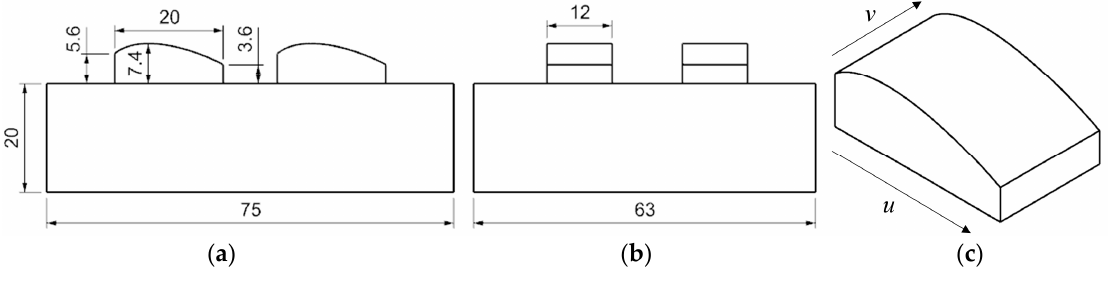
Figure 2. Design of Surface one; ( a ) front view; ( b ) side view; ( c ) isometric view.